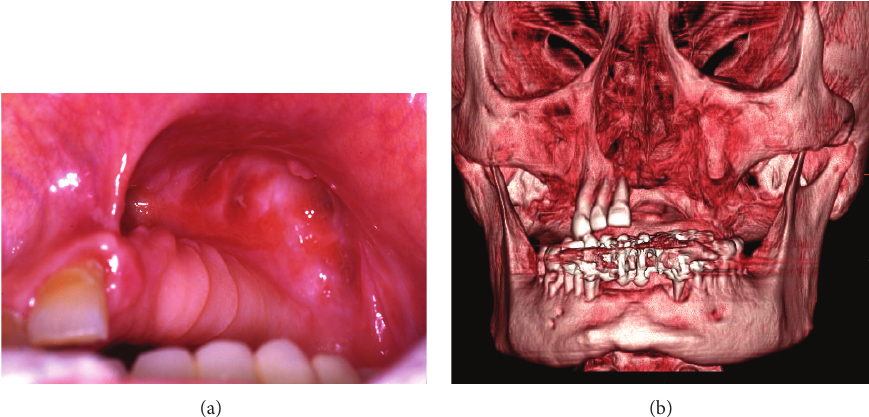
Figure 2: Complete bone and mucosal healing and multislice spiral CT with 3D reconstruction 13 months after surgery and intracavitary application of Aminogam gel.